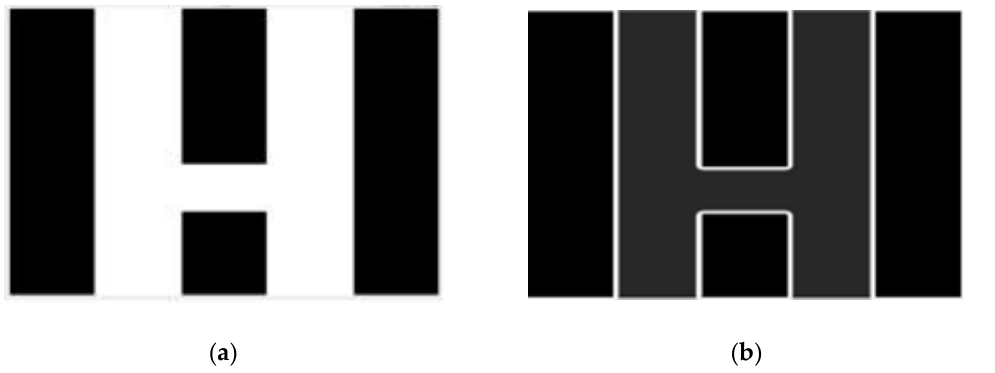
Figure 6. High-pass filtering of IDT local images with high-pass filtering: ( a ) partial diagram of IDT; ( b ) after filtering the graph by Gaussian high-pass filter .